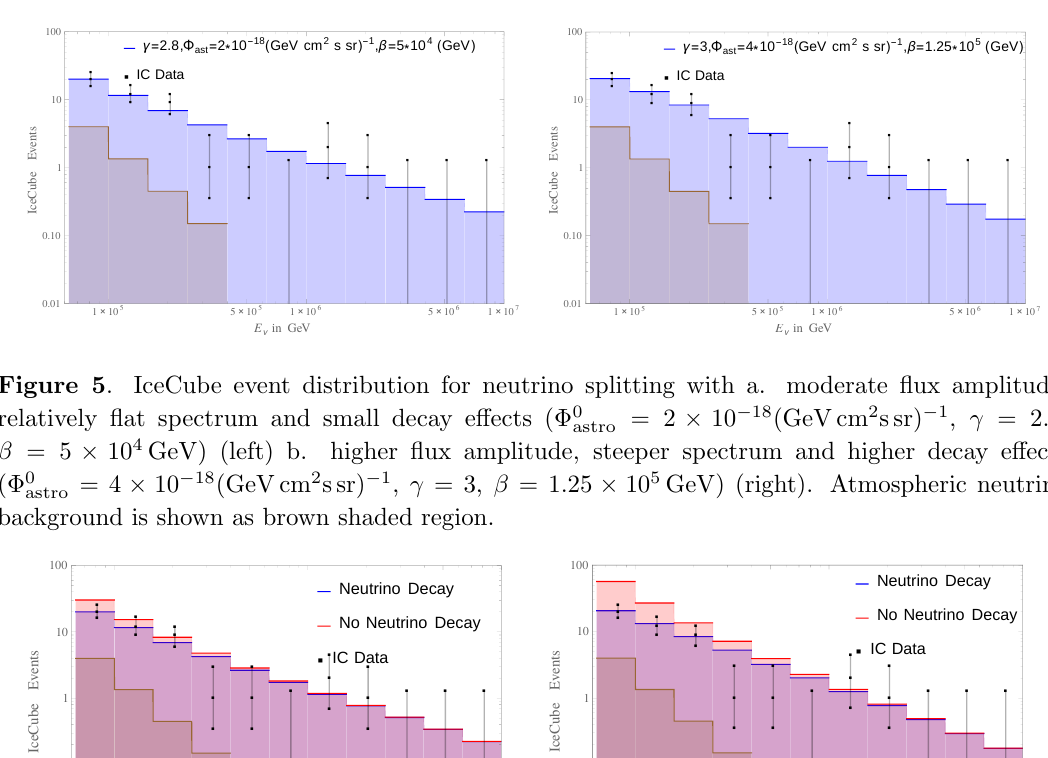
= 5 (cid:2) 10 (cid:0) 18 (GeV cm 2 s sr) (cid:0) 1 , (cid:13) = 3 astro